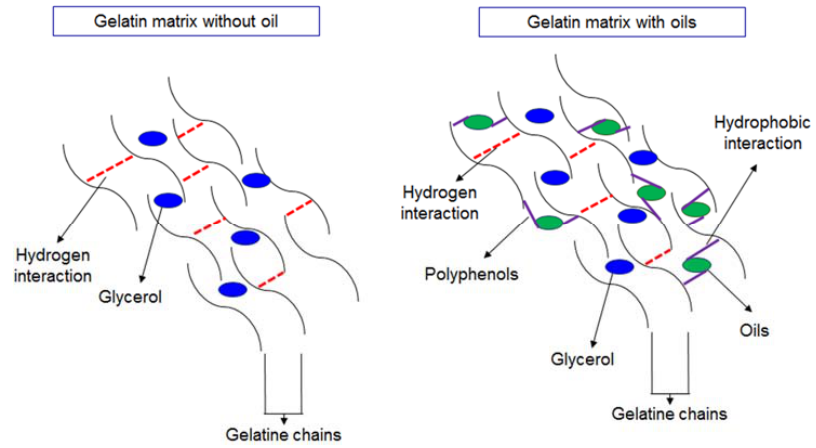
Figure 3. Scheme of gelatin matrix interactions with and without oil incorporation.